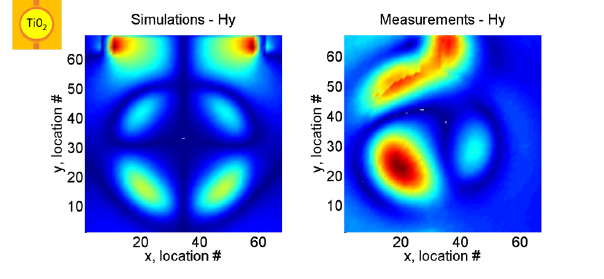
Figure 12: | H y | magnitude of the magnetic field for simula- tions (CST (cid:114) , left) and measurements (right) in the vicinity of the ring resonator covered by TiO 2 at f = 2 . 66